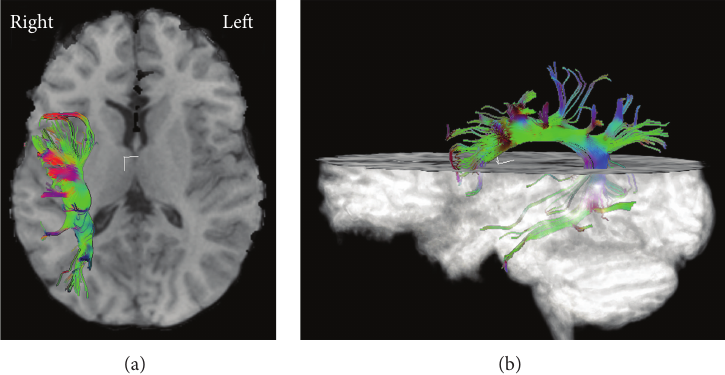
Figure4:Superior(a)andleftlateral(b)viewsofthearcuatefasciculus(AF)inapatientwithnodysplasticinvolvementofthelefthemisphere. Images demonstrate no identifiable left AF. This right-handed patient was impaired with respect to